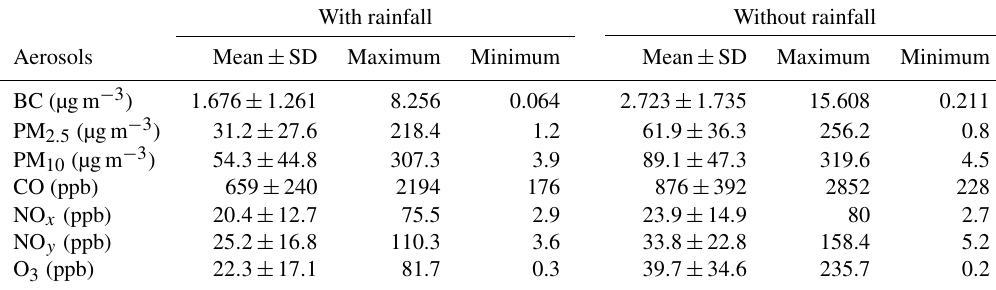
Table 6. Statistics of aerosols with and without rainfall at the Gulou site during the study period. With rainfall Without rainfall Aerosols Mean ± SD Maximum Minimum Mean ± SD